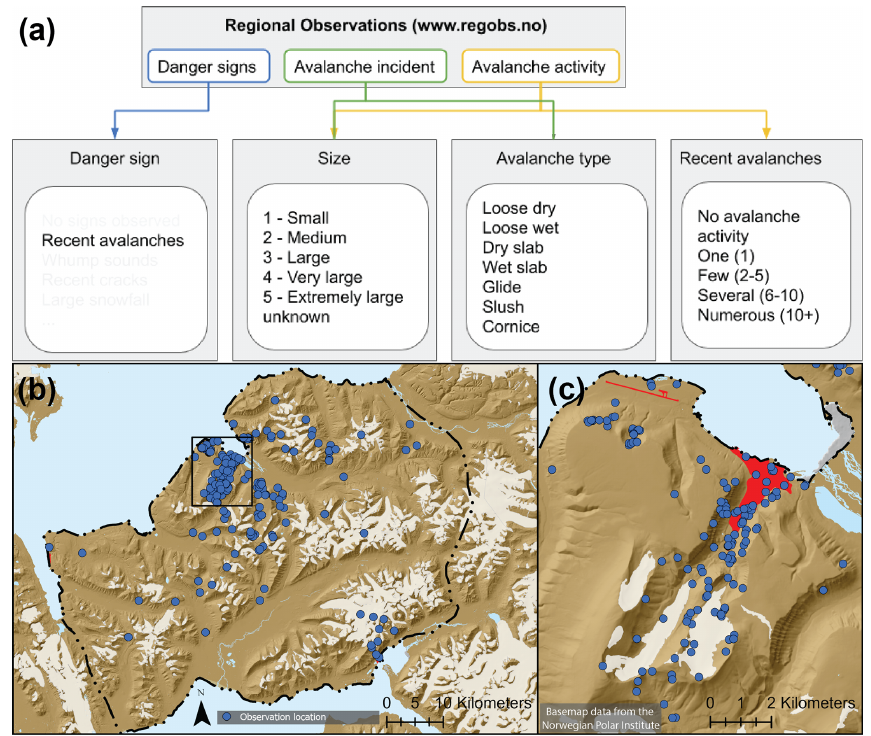
Figure 2. Overview of the regObs observations employed in this work. Panel (a) shows a schematic displaying the regObs observation types retrieved in this work, the parameters we analyzed from each observation type, and the values for each parameter available for user selection. Note that avalanche accidents are not displayed in this figure as they have the same parameters as avalanche incidents and, as of June 2020, are only available for input on the website and not the mobile application. Panel (b) shows the distribution of observations reporting avalanche activity used in this work, while panel (c) highlights observation density near Longyearbyen in the region indicated in panel (b) .